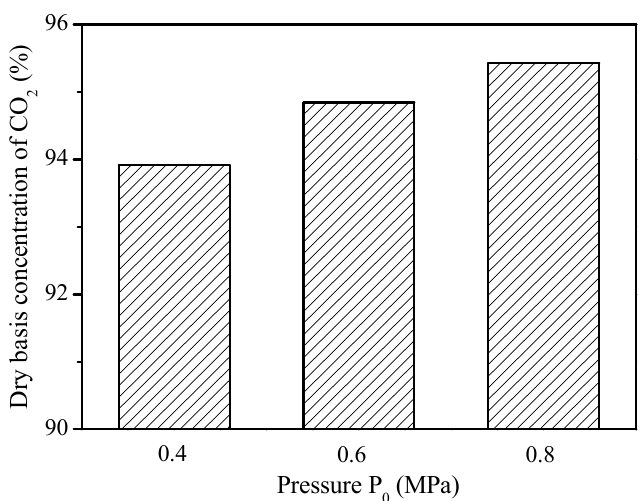
Figure 15. Effect of pressure on the CO 2 concentration (dry basis) at the outlet of the fuel reactor.